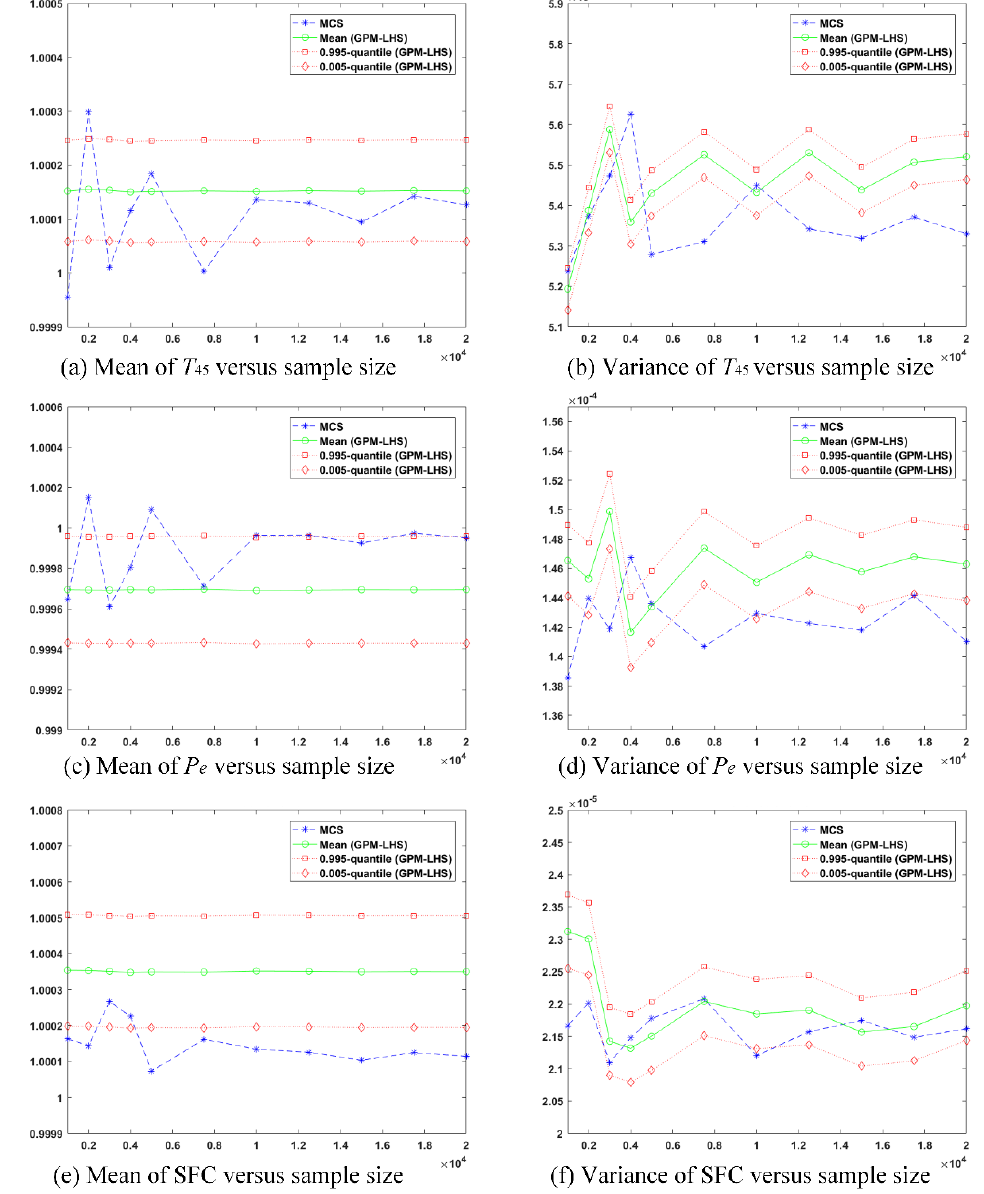
T versus sample size; ( b ) variance of Figure 4. ( a ) Mean of Figure 4. ( a ) Mean of T 45 versus sample size; ( b ) variance of T 45 versus sample size; ( c ) mean of 45 P versus sample size; ( e ) mean of SFC versus sample size; ( f ) variance of SFC versus sample size. P e versus sample size; ( d ) variance of P e versus sample size; ( e ) mean of SFC versus sample size; ( d ) variance of e ( f ) variance of SFC versus sample